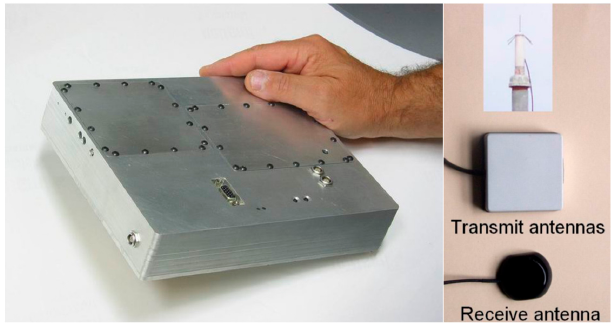
Figure 4. First generation LocataLite hardware and antennas [18].